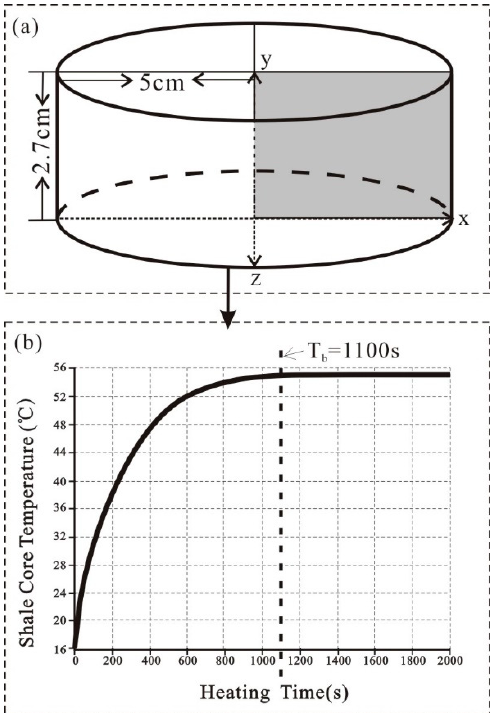
Figure 8. The process of calculating the temperature balance time of sample X1 using ANSYS software. ( a ) Mathematical model; ( b ) Calculation results.